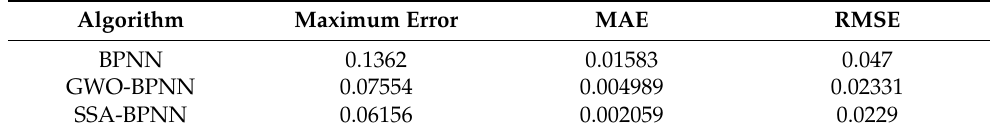
Figure 6. Test sample verification results: ( a ) Comparison of predicted values and true values. ( b ) Predicted error values. Table 1. Performance comparison of different pre-aim time regulators.